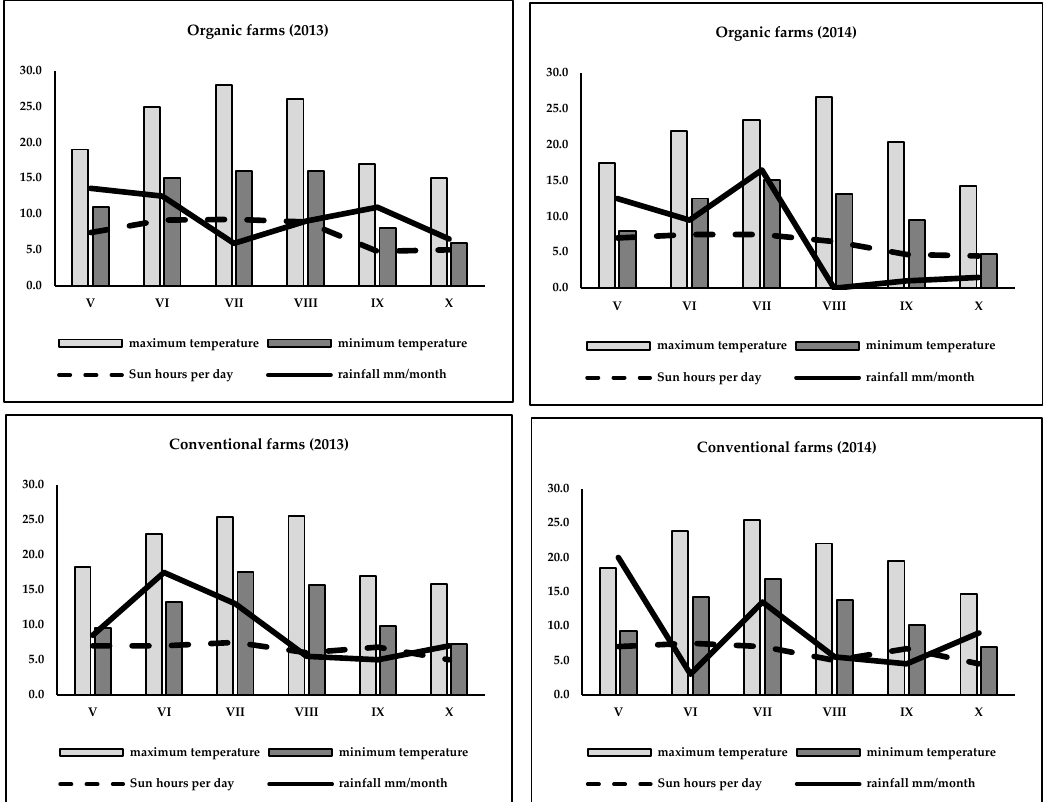
Figure 1. Weather conditions in experimental farms (organic and conventional) 2013-2014 in time of raspberry fruits development.